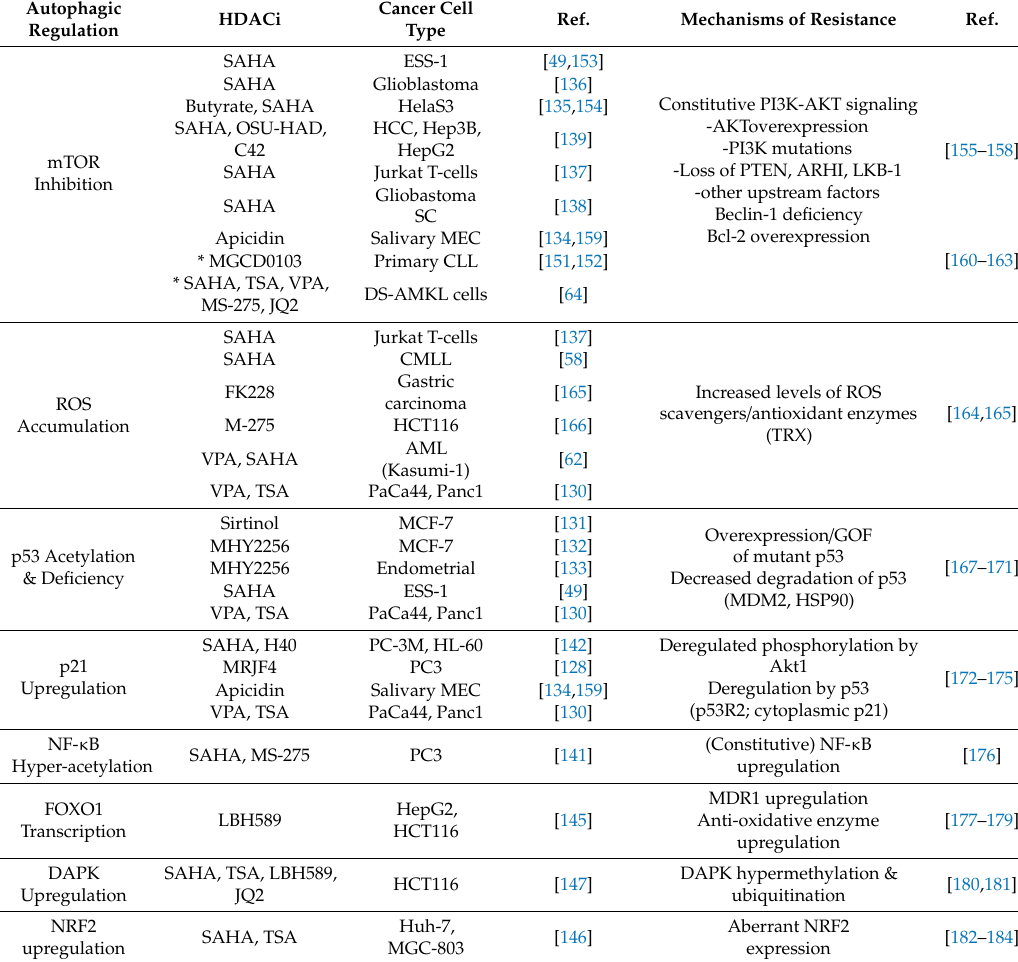
Table 1. Mechanisms of HDACi-induced autophagy and potential mechanisms of